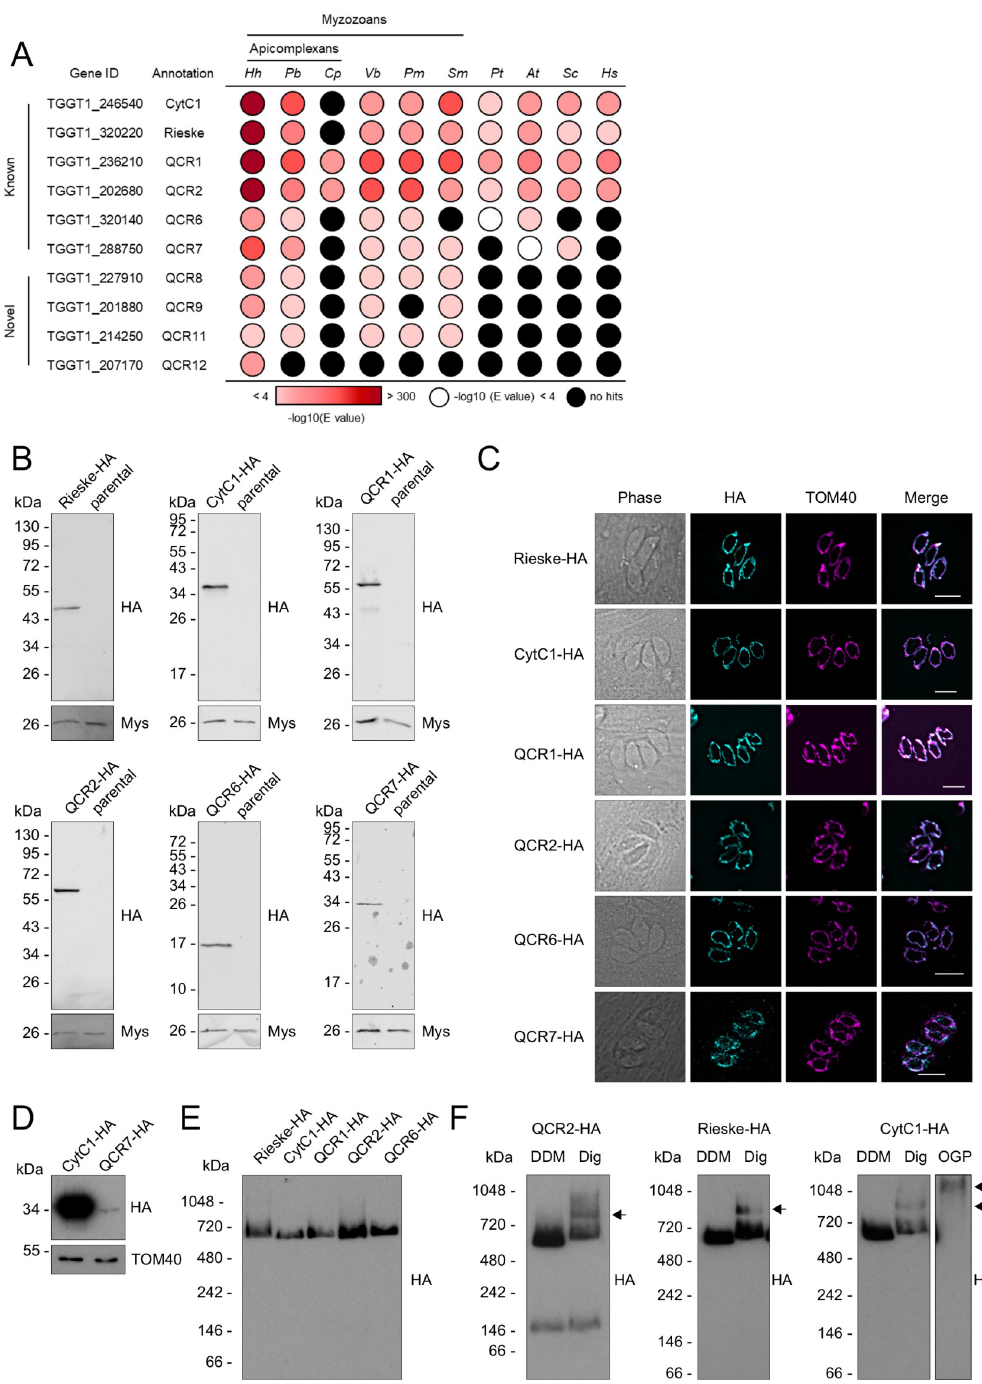
Fig 4. Analysis of putative Toxoplasma complex III subunits. (A) Table showing the previously predicted (known) and complexome identified putative novel (novel) complex III subunits and their homology distribution across key groups. Homology searches were performed using the HMMER tool [57]. Coloured circles refer to the e-value from the HMMER search: white indicates a hit with an e-value above 0.0001, black indicates no hits, and red indicates hits with an e-value below 0.0001, as indicated in the coloured scale. Full data are given in S7 Table . Hh : Hammondia hammondi ; Pb : Plasmodium berghei ; Cp : Cryptosporidium parvun ; Cyryptosporidium muris ; Vb : Vitrella brassicaformis ; Pm : Perkinsus marinus ; Sm : Symbiodinium microadriaticum ; Pt : Paramecium tetraurelia ; At : Arabidopsis thaliana ; Sc : Saccharomyces cerevisiae ; Hs : Homo sapiens . (B) Immunoblot analysis of putative complex III subunits endogenously tagged with an triple-HA epitope